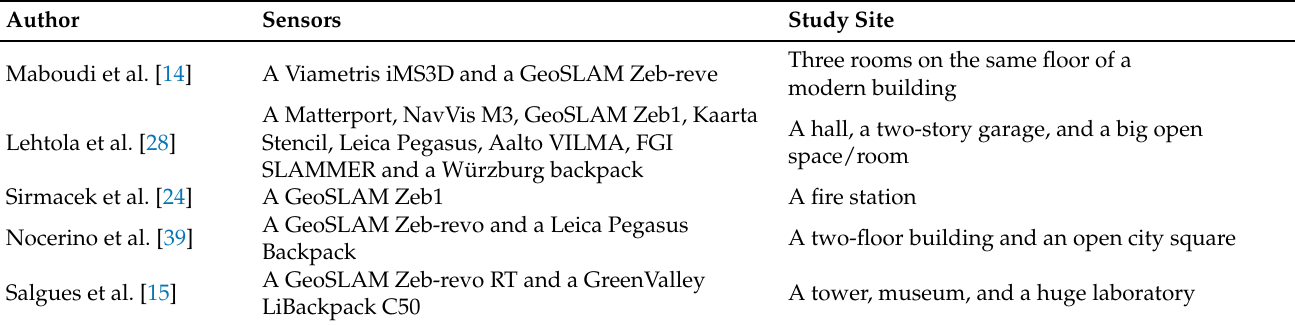
Table 1. The study sites and sensors of various authors. are